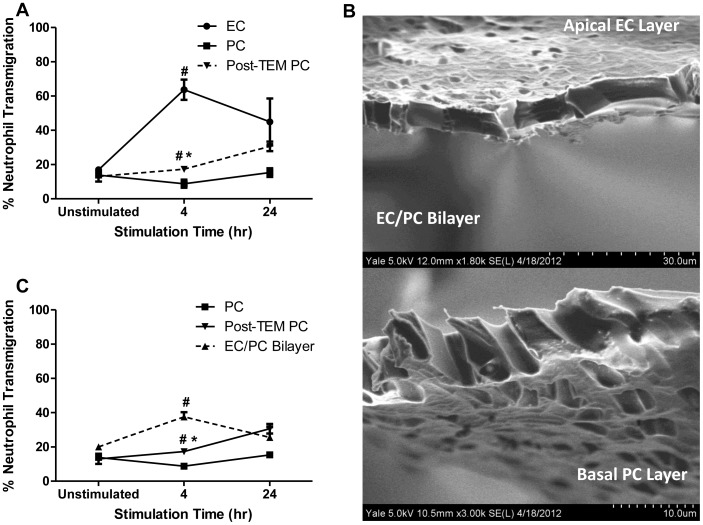
Neutrophil transmigration across IL-1β activated EC or PC monolayers.Freshly isolated neutrophils were seeded onto monolayers (activated with IL-1β for 4 or 24 hr) and allowed to transmigrate for 1 hr. Data are represented as a (A) line plot of naive neutrophil transmigration across EC or PC, and transendothelial migrated neutrophils (Post-TEM) transmigration across PC. Figure 3B is demonstrative of (B) EC and PC co-cultured on a single membrane to form an EC/PC bilayer. (C) Freshly isolated naive neutrophils were seeded onto EC/PC bilayers (activated with IL-1β for 4 or 24 hr) and allowed to transmigrate for 1 hr. Line data represent average neutrophil transmigration ± SEM. #P<0.05, when compared to 4 hr activated PC, *P<0.05, when compared to 4 hr activated EC or EC/PC Bilayer.